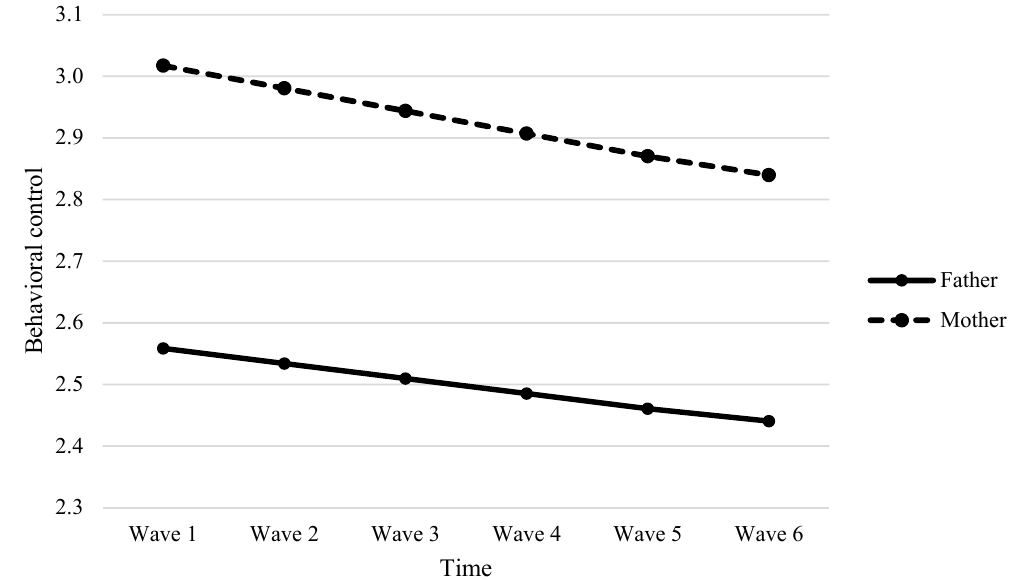
Figure 1. Fitted trajectories of behavioral control of mothers and fathers. The figures were plotted based on Model 4a shown in Table 6.